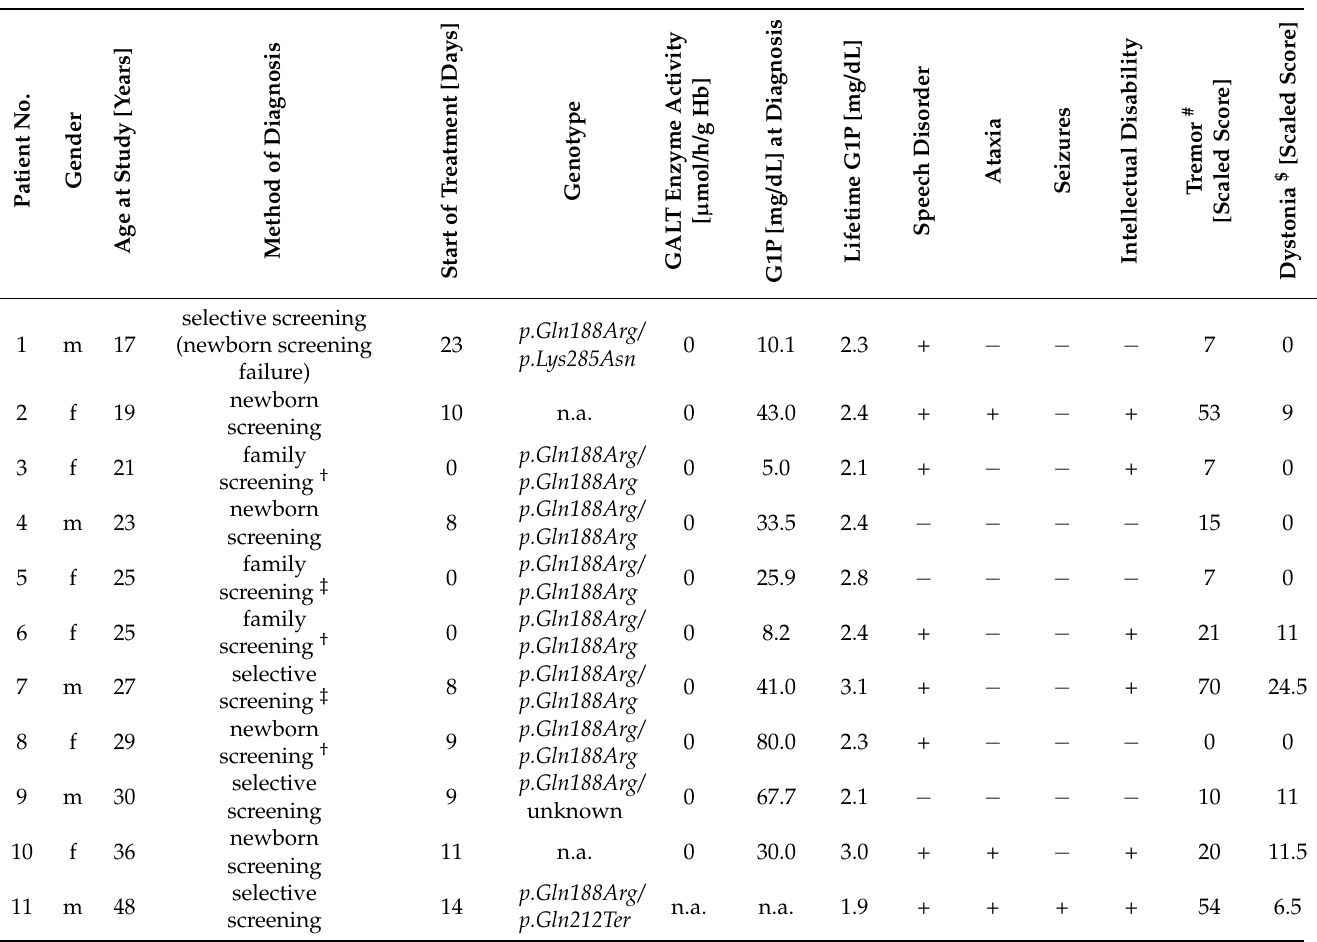
Table 1. Demographic and disease-related information of classical galactosemia